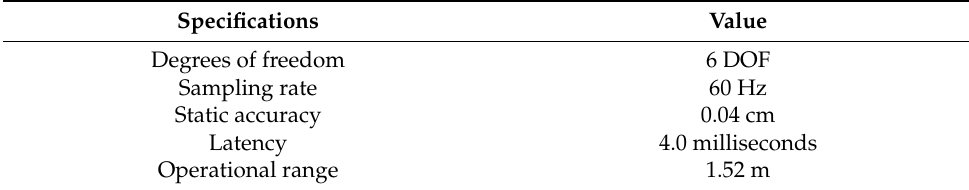
Table 1. The specification of the FASTRAK 3D motion tracker.